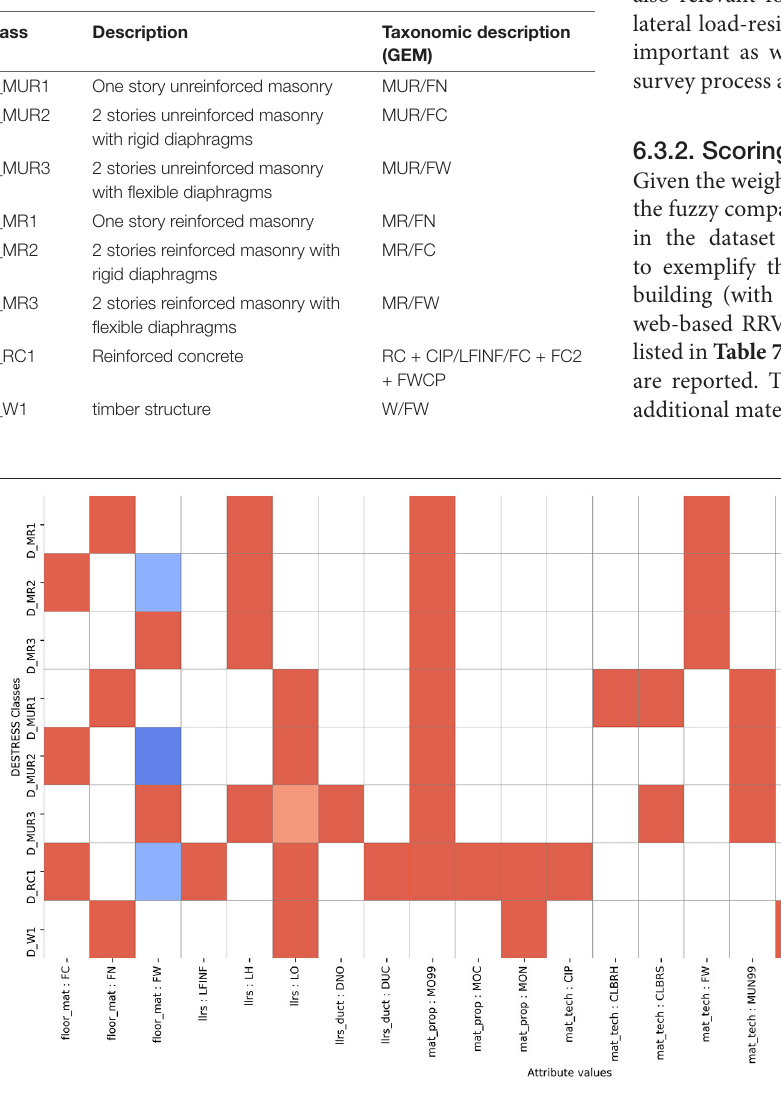
TABLE 4 | Building classes defining the DESTRESS scheme.